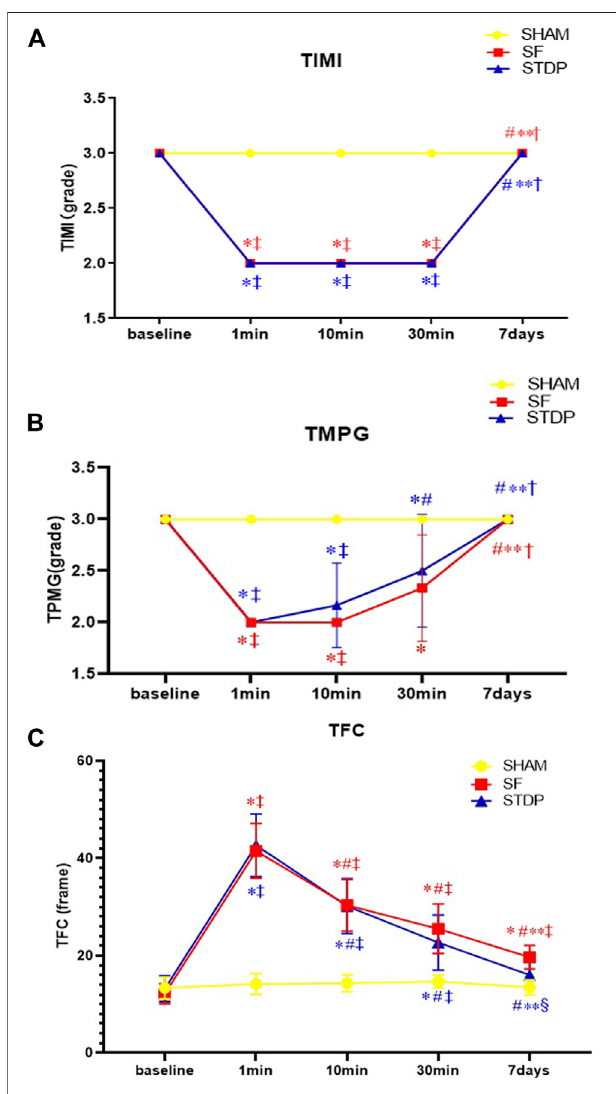
FIGURE 3 | Line chart of LAD slow fl ow formation after coronary microembolism (Angiographic parameters at baseline, 1, 10, 30 min, and 7 days post LAD coronary microsphere injection). (A – C) : Line chart of angiographic parameters (TIMI, TMPG, and TFC) at baseline, 1, 10, 30 min, and 7 days post LAD coronary microsphere injection. Data are presented as the mean ± SD. p < 0.05 *vs. baseline, #vs. 1 min, **vs. 10 min, † vs. 30 min, ‡ vs. Sham group, and §vs. SF group ( n = 6 for each group).